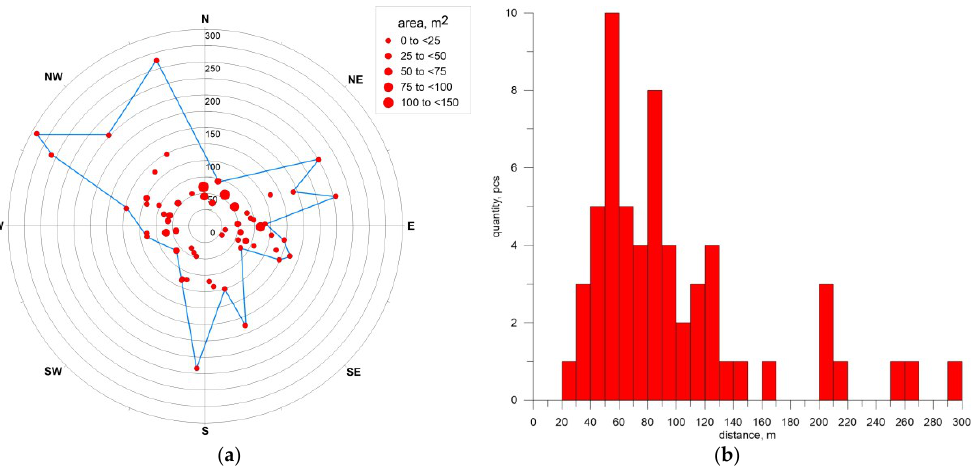
Figure 11. Distribution of impact hollows around GEC-2: ( a ) position of impact hollows around AMP; diameter of the red circle is proportional to the area of the hollow; the line connecting the farthest points outlines the impactor scattering zone—zone A; ( b ) distribution of the number of impact hollows in relation to the distance from the AMP.